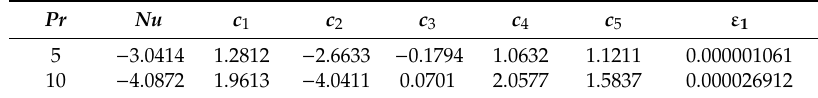
Table 6. The values of error bound ε and coe ffi cients of multiple quadratic regression for estimated NuRe 1/2 x due to variations in Ec and Nr are analyzed as. Pr Nu c